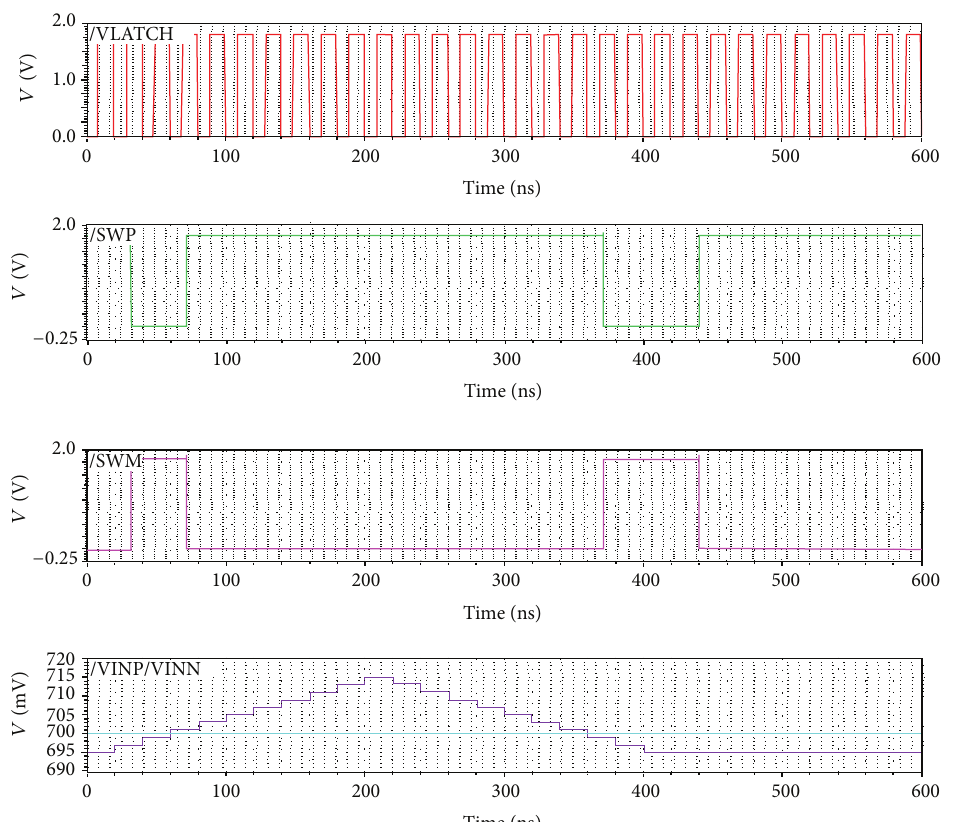
Figure 2: Transient simulation of the comparator input signals, VLATCH signal, and output signals (SWP and SWM) using Virtuoso